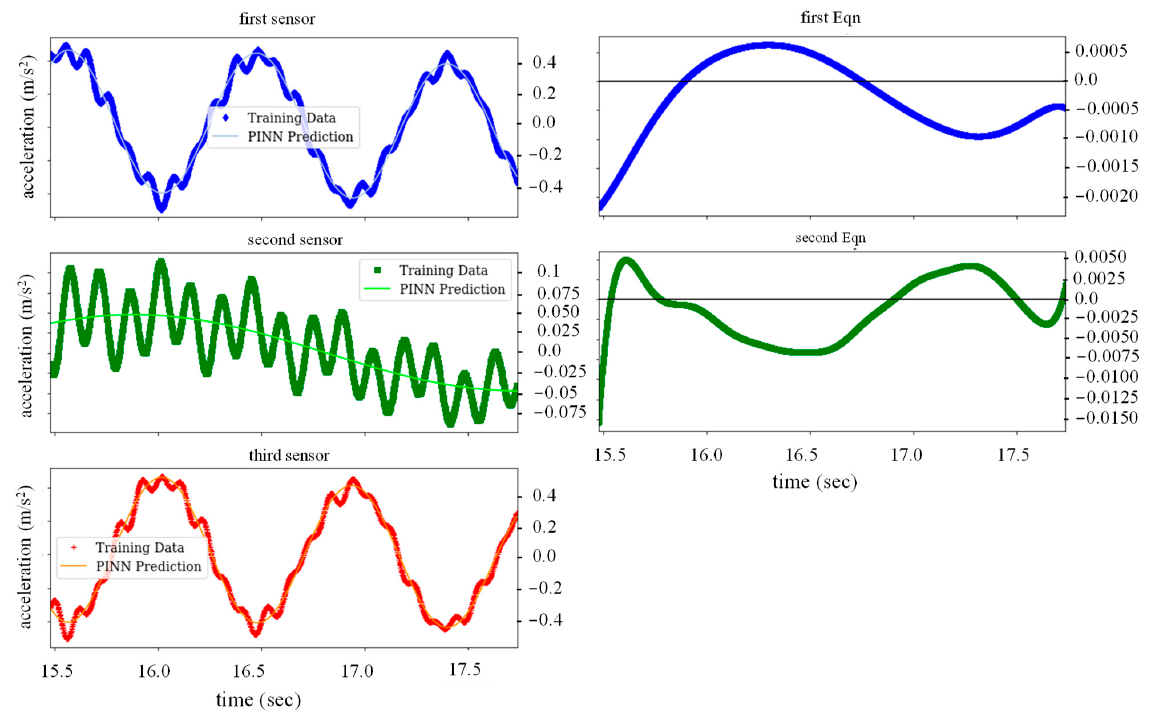
Figure 31. Sequential PINN estimations during the training period with acceleration input.